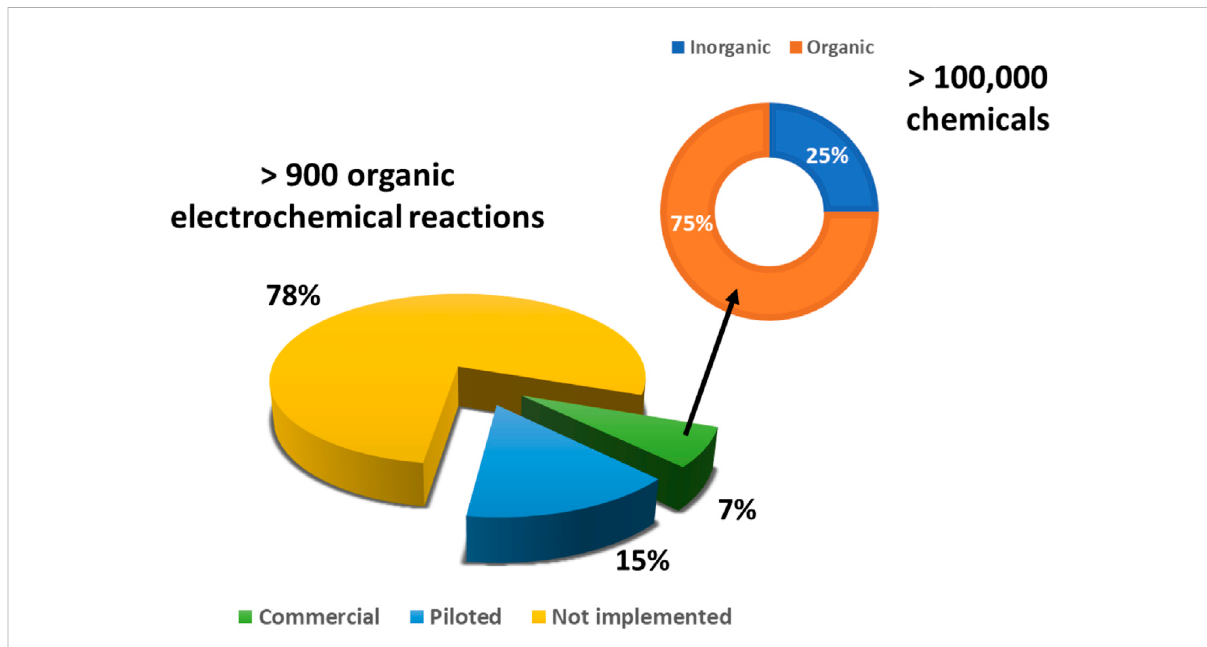
FIGURE 11 Electrochemical organic processes: commercial/pilot overview (Authors ’ graphic inspired by Sequeira and Santos,